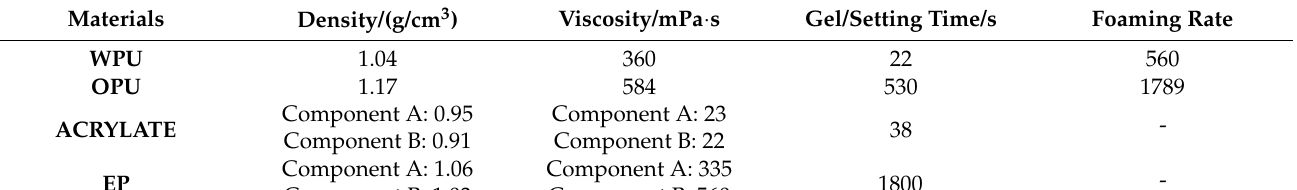
Table 1. Basic physical properties of polymer slurry.